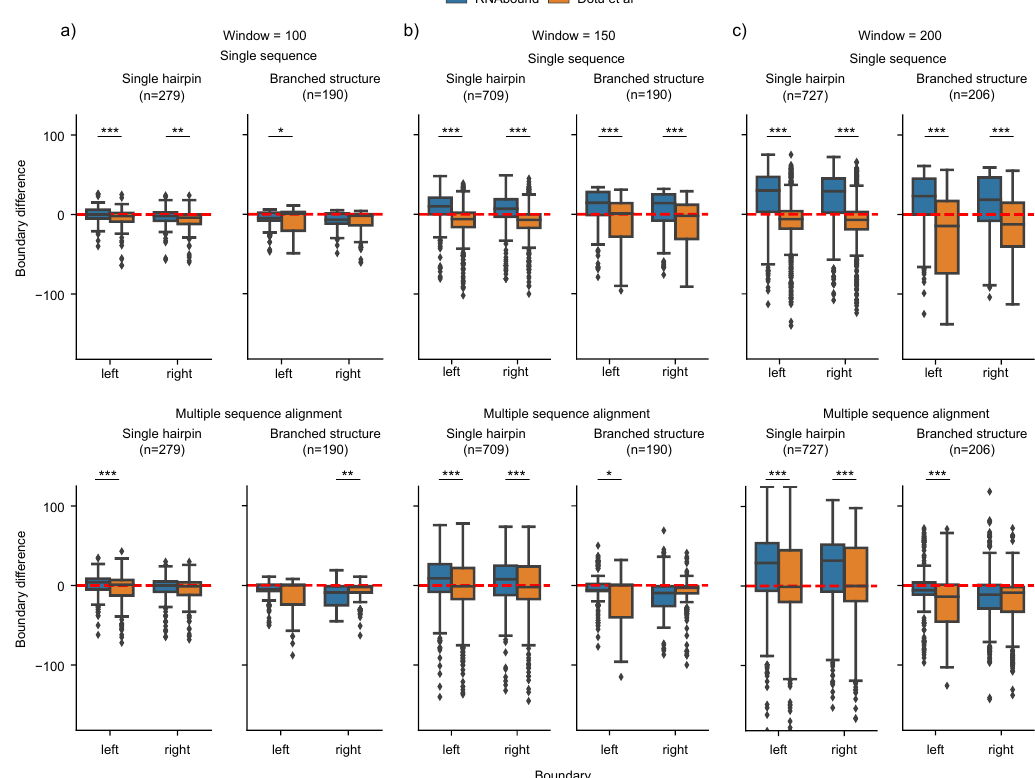
Figure 1. Comparison of actual and predicted boundaries by RNAbound and Dotu et al. on the benchmarking dataset across all families (Table 1) of different window sizes 100 ( a ), 150 ( b ), and 200 ( c ). Under each window category, the top row represents the results obtained from the single sequence and the bottom from multiple sequence alignment. In both cases, we considered structures whose actual base pair start and end positions are within the respective window size. The value on the y-axis indicates if the predicted and actual boundaries are the same (if the value is zero), in excess (positive) or short of (negative) compared to the actual boundaries. The distributions that showed significant difference based on the two-sided Wilcoxon rank-sum test are indicated with asterisk symbol (*** p < 0.001, ** p < 0.01, and * p <